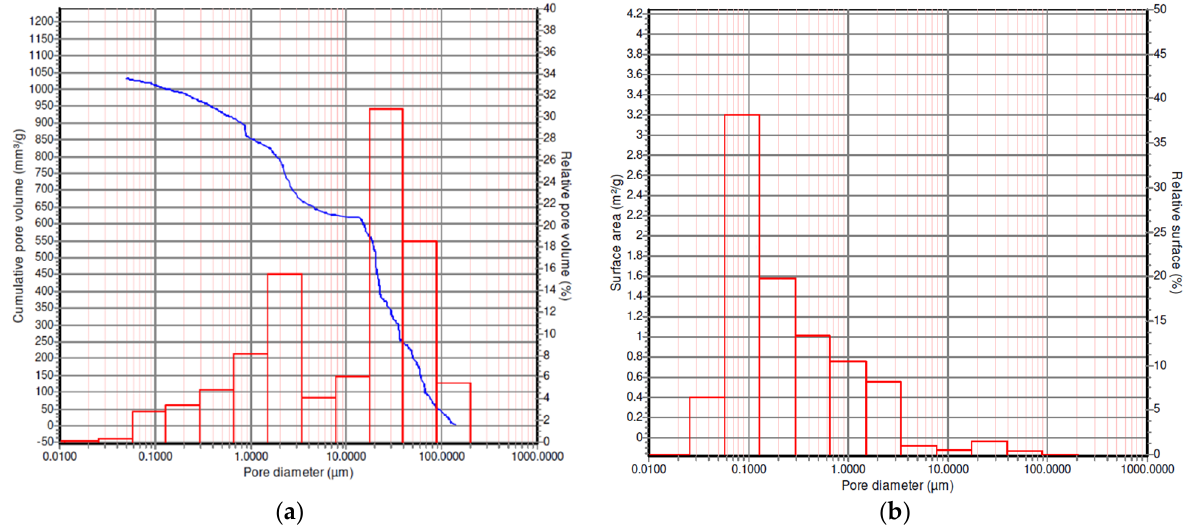
Table 2. Porosity data of polylactic-co-glycolic acid (PLGA) scaffolds.